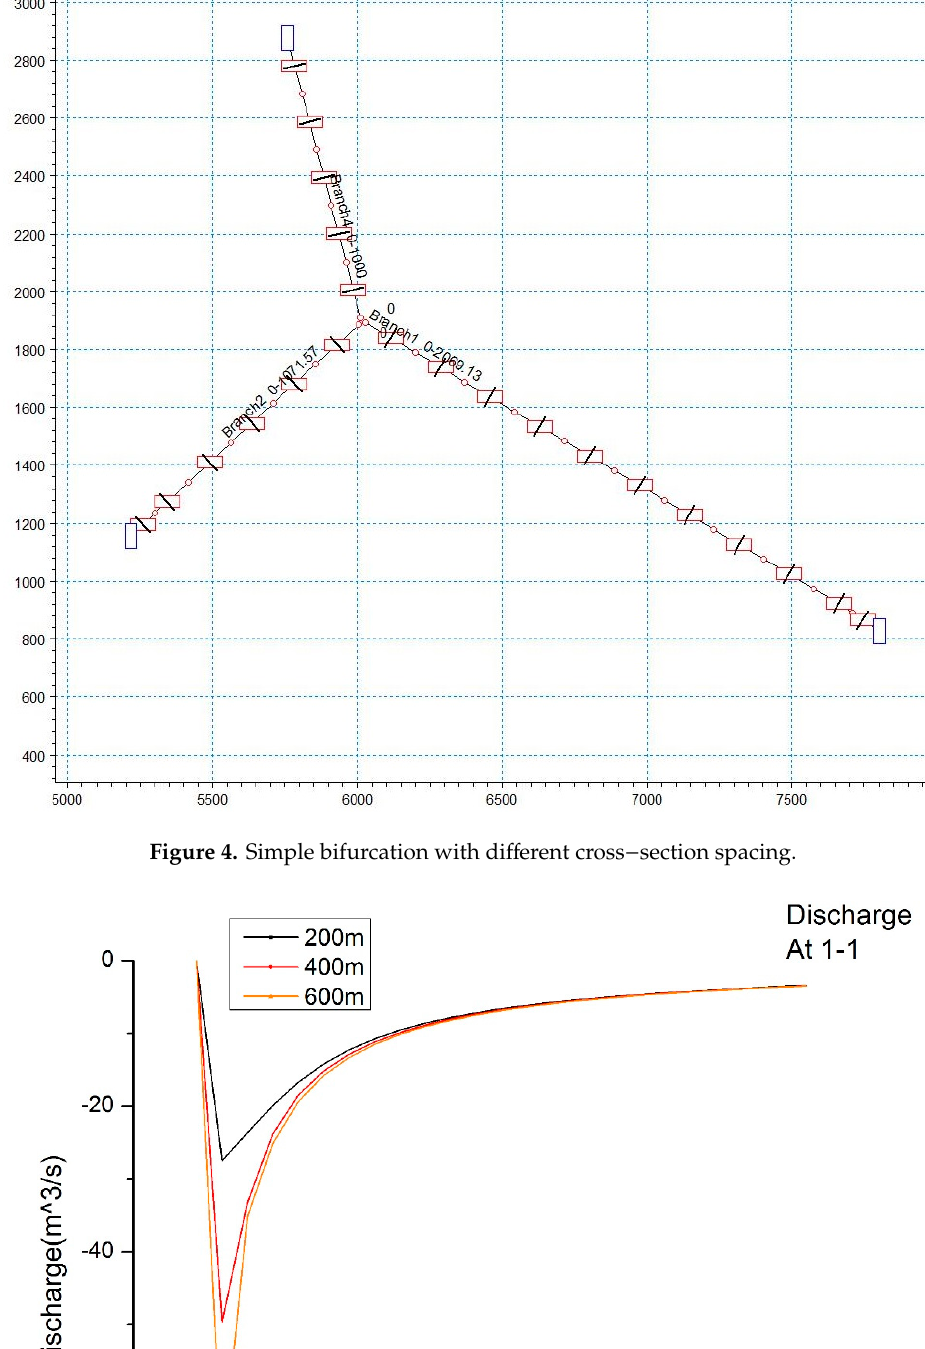
Figure 5. Simple bifurcation with different cross − section spacing.